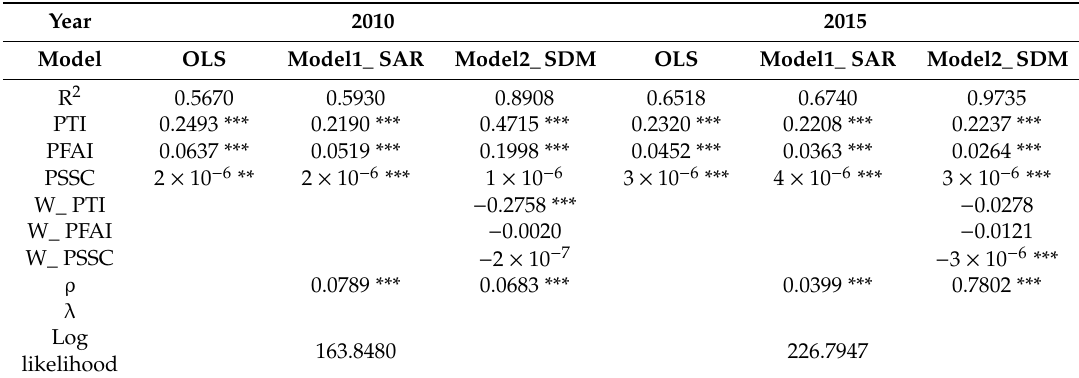
Table 4. Spatial regression